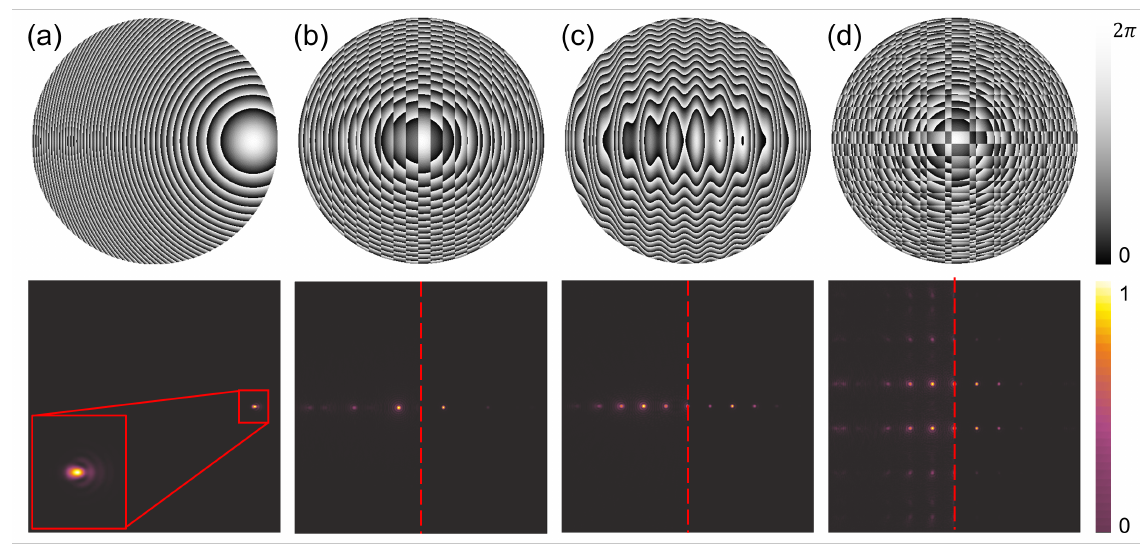
Figure 8. Different diffractive structures redirecting and splitting the incident radiation. The upper panel illustrates the phase delay maps introduced by each structure. The lower panel illustrates the intensity distribution in the focal plane in ( a ). Additionally, due to the fact the distributions are symmetrical in ( b – d ) the focal plane is illustrated as two halves—left corresponding to amplitude distribution and right the intensity distribution. The structure in ( a ) is a shifted lens to redirect and focus the radiation out of the optical axis. The inset shows the magnification of focal spot which will have more aberrations when shifted further from the optical axis. The structure in ( b ) is the binary phase grating joined with the converging lens. It forms two strong spots aside optical axis. The structure in ( c ) is the sinusoidal phase grating joined with the converging lens. Due to the modified changes of the phase the spots corresponding to other order of diffraction than ± 1st are also visible. The structure in ( d ) is the Dammann grating forming the matrix of 3 × 2 points joined with the converging lens. In this case additional orders are very noticeable. Thus, in case of redirecting the beam there in a need to optimized the phase delay map to suppress the influence of undesired spurious focal